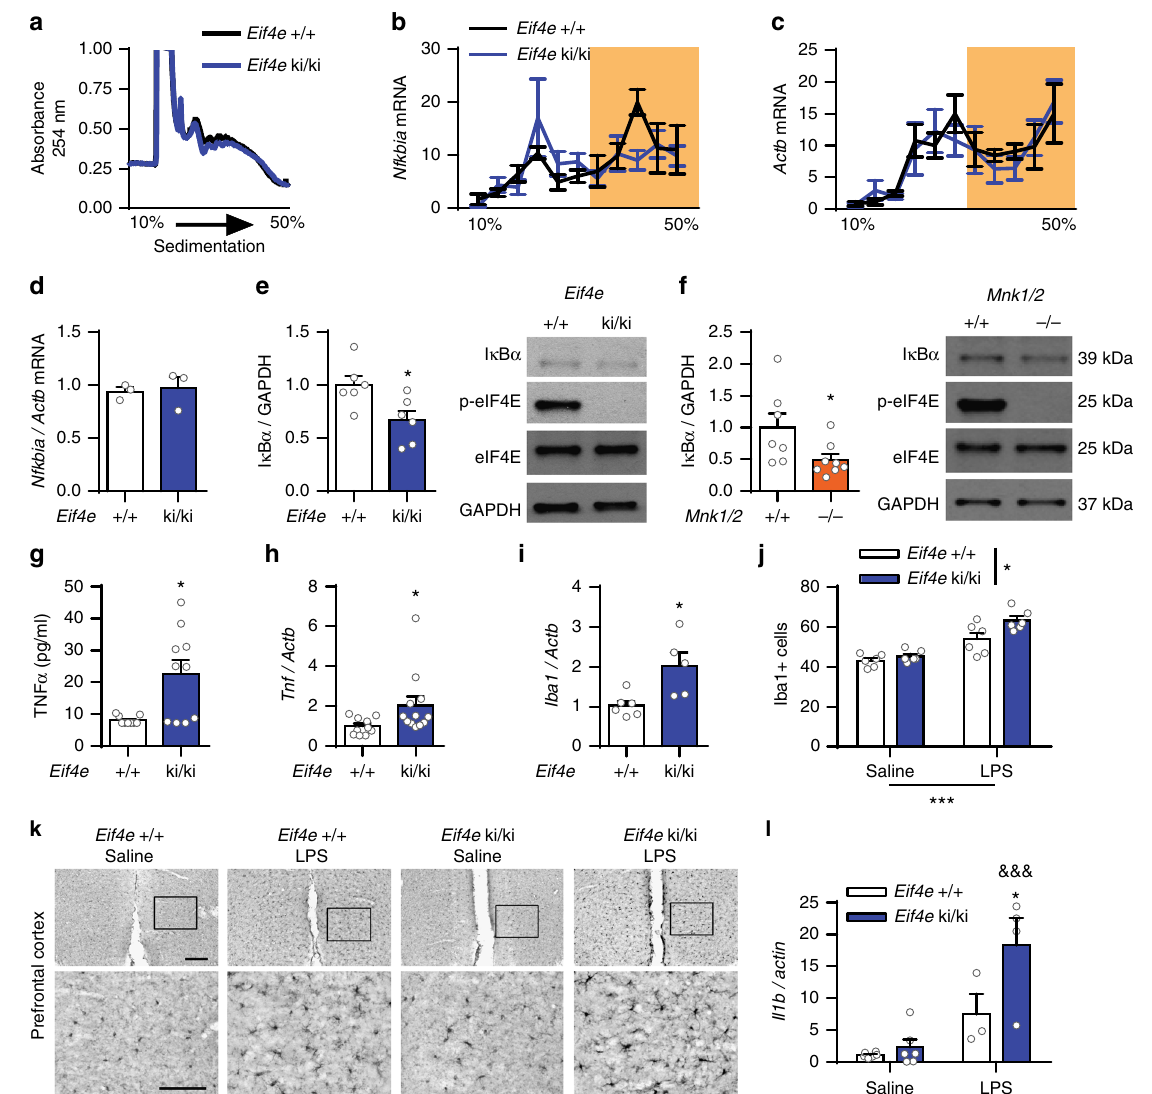
Fig. 5 Translation of Nfkbia mRNA is reduced in Eif4e ki/ki mice. a Representative polysome pro fi le of cortex-hippocampus from Eif4e + / + and ki/ki mice (1 mouse per genotype). b Distribution of the Nfkbia mRNA in the polysome fractions of wild-type and Eif4e ki/ki mice ( n = 4 Eif4e + / + ; n = 5 Eif4e ki/ki). c , Actb mRNA was measured in both mouse strains as a control. d Total mRNA levels of Nfkbia in the cortex-hippocampus of Eif4e + / + and ki/ki mice. e Average protein levels and representative western blot images of the Nfkbia mRNA product, I κ B α , in the mPFC of Eif4e wild-type and ki/ki mice ( n = 6/ group). f Average protein levels and representative western blot images I κ B α , in the mPFC of Mnk1/2 + / + and − / − mice ( n = 7 Mnk1/2 + / + ; n = 8 Mnk1/2 − / − ). g Levels of the cytokine tumor necrosis factor α (TNF α ) in the mPFC in wild-type and Eif4e ki/ki mice ( n = 9 Eif4e + / + ; n = 10 Eif4e ki/ki). h Total levels of Tnf mRNA in the mPFC in wild-type and Eif4e mutant mice ( n = 10 Eif4e + / + ; n = 12 Eif4e ki/ki). i mRNA levels of the microglial marker Iba1 ( Aif1 ) in the mPFC in wild-type and Eif4e mutant mice ( n = 6 Eif4e + / + ; n = 5 Eif4e ki/ki). j Number of Iba1 positive cells (Iba1 + ) per 0.01 mm 2 of mPFC from wild- type and Eif4e ki/ki mice 48 h after saline or LPS (IP, 2.5 mg kg − 1 ) treatment ( n = 3/group). k Representative images of the mPFC of wild-type or Eif4e ki/ki mice 48 h after saline or LPS treatment. l mRNA levels of Il1b in the mPFC of wild-type or Eif4e ki/ki mice 48 h after saline or LPS treatment ( n = 6 Eif4e + / + Saline, n = 6 Eif4e ki/ki Saline, n = 3 Eif4e + / + LPS; n = 4 Eif4e ki/ki LPS). * p < 0.05, *** p < 0.001 vs. wild-type; &&& p < 0.001 vs. saline-treated Eif4e ki/ki (see Supplementary Table 2 for detailed results of statistical We also determined that adult hippocampal progenitor proliferation (Ki67 + cells, Supplementary Fig. 5a, b), survival (BrdU + cells, 28 d after treatment, Supplementary Fig. 5c, d) and differentiation (DCX + cells, Supplementary Fig. 5e, f) was not changed in male and female Eif4e ki/ki mice.